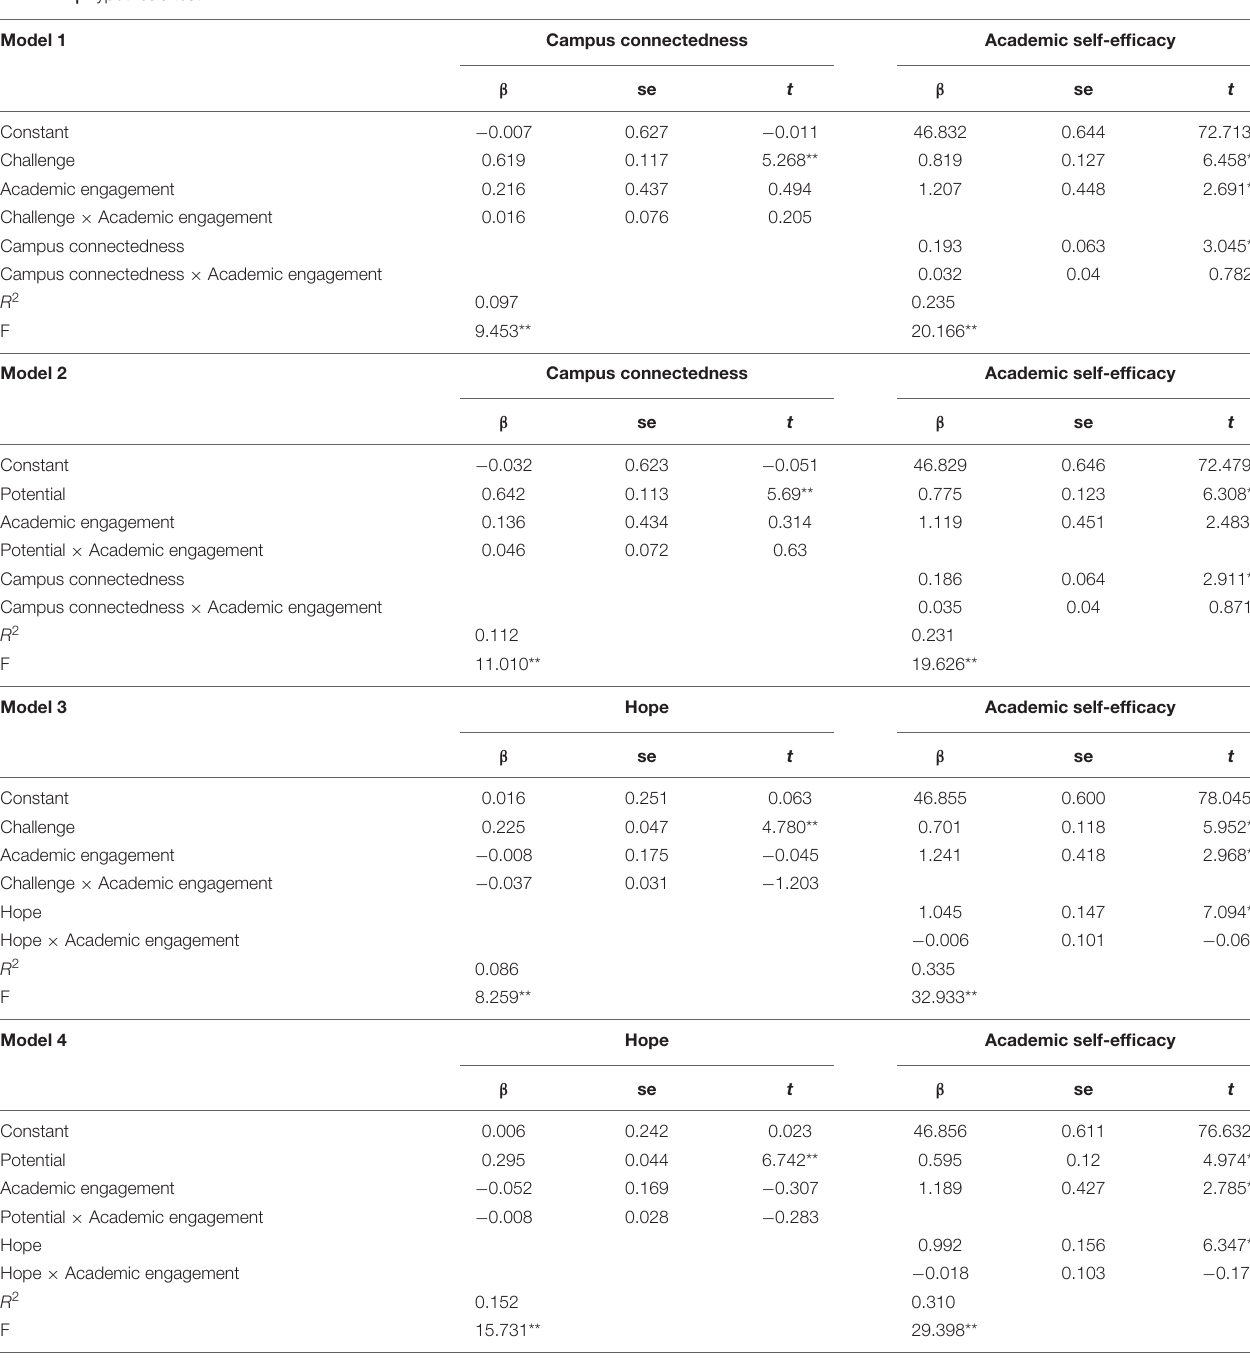
TABLE 2 | Hypothesis